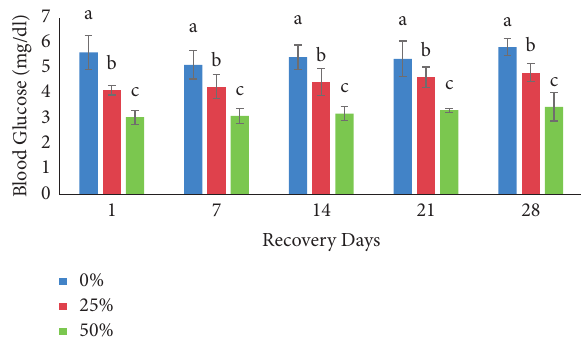
Figure 5: Glucose level (mean ± SD) at different time intervals in malathion-free water during recovery experiment. Different su- perscript letters are significantly different at p < 0 .